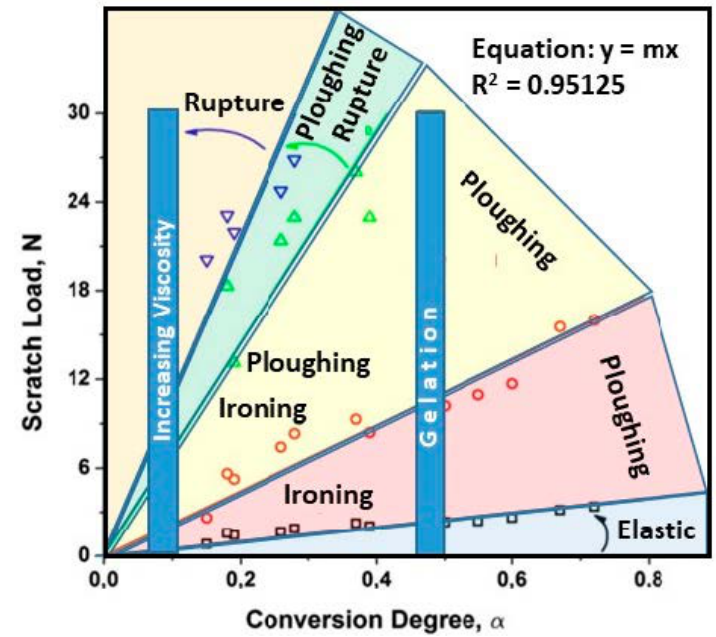
Figure 7. Scratch Map, reproduced from [88].